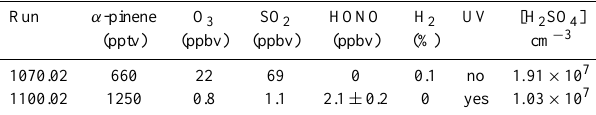
Table 1. Conditions of selected runs. The given values correspond to the period with constant [H 2 SO 4